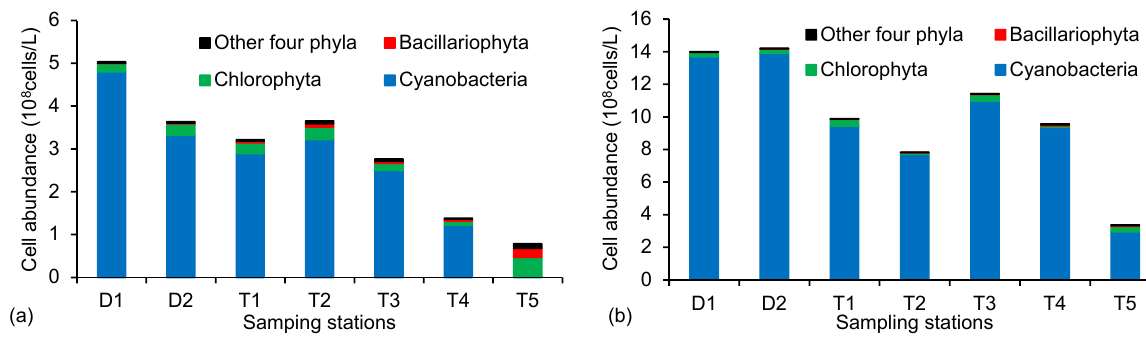
Figure 3. The phytoplankton compositions at the same seven stations ( a ) in June ( b ) in September (Other four phyla: Xanthophyta, Euglenophyta, Dinophyta and Cryptophyta).